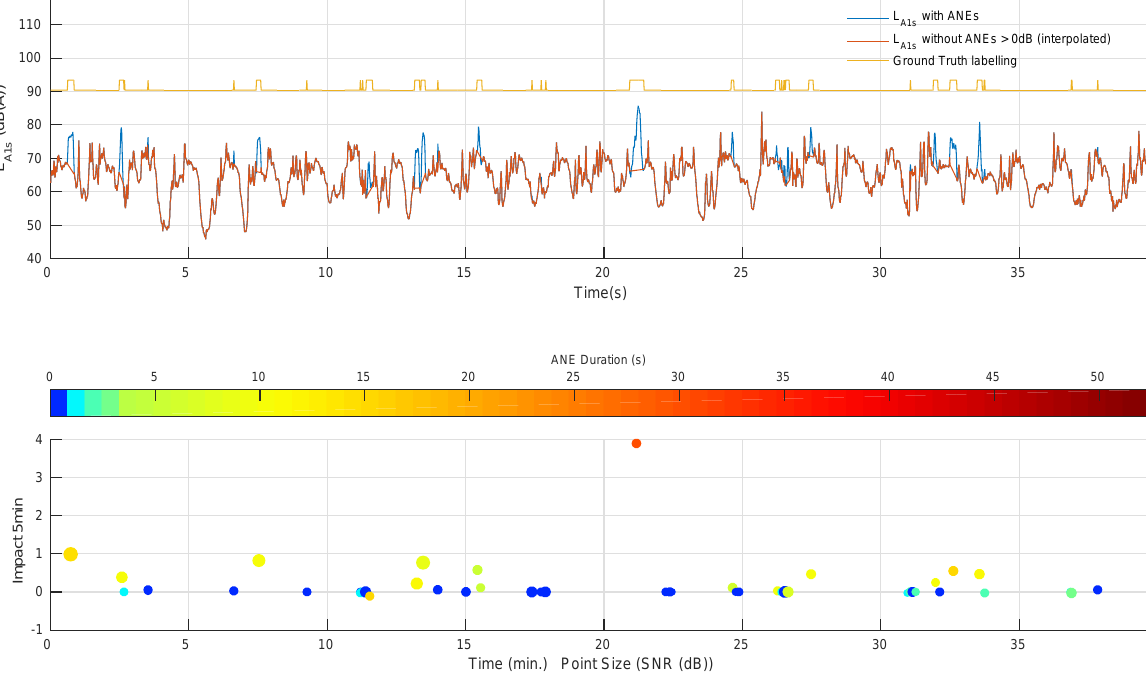
Figure 7: A detailed example of the Site 5 of the Milan pilot area recording [43], showing the bias of the ANEs on the L A 300 s computation, including the evolution of the L curve with and without ANEs obtained from the ground truth manual labelling A 1 s